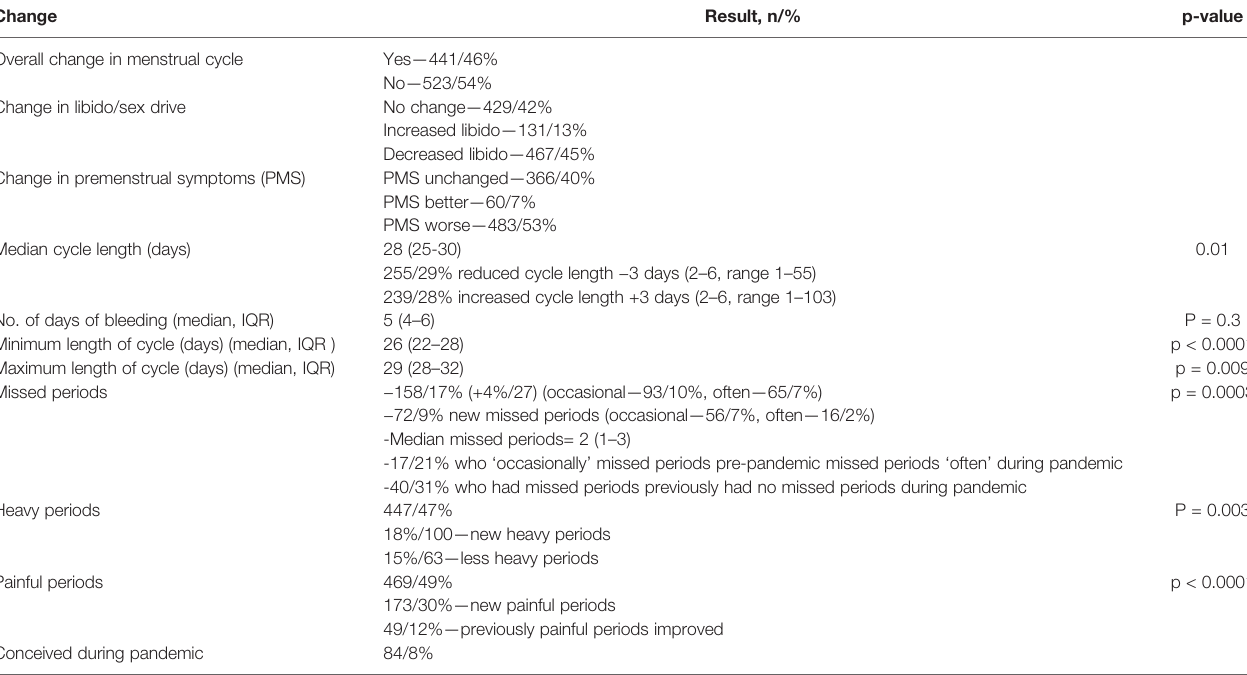
TABLE 3 | Menstrual cycle changes during the Covid-19 pandemic.